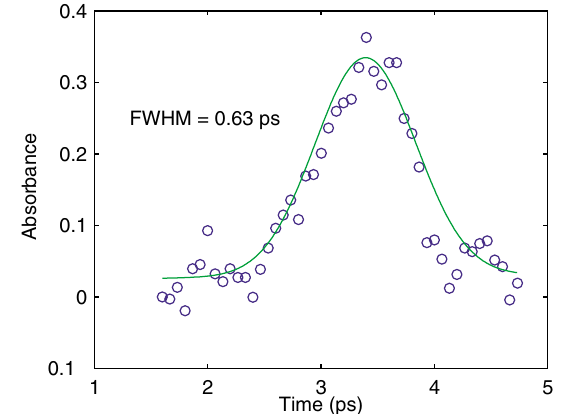
FIG. 12. (Color) Pulse length measurement of the HGHG out- put using two-photon absorption pump-probe autocorrelation for a seed power of 1.8